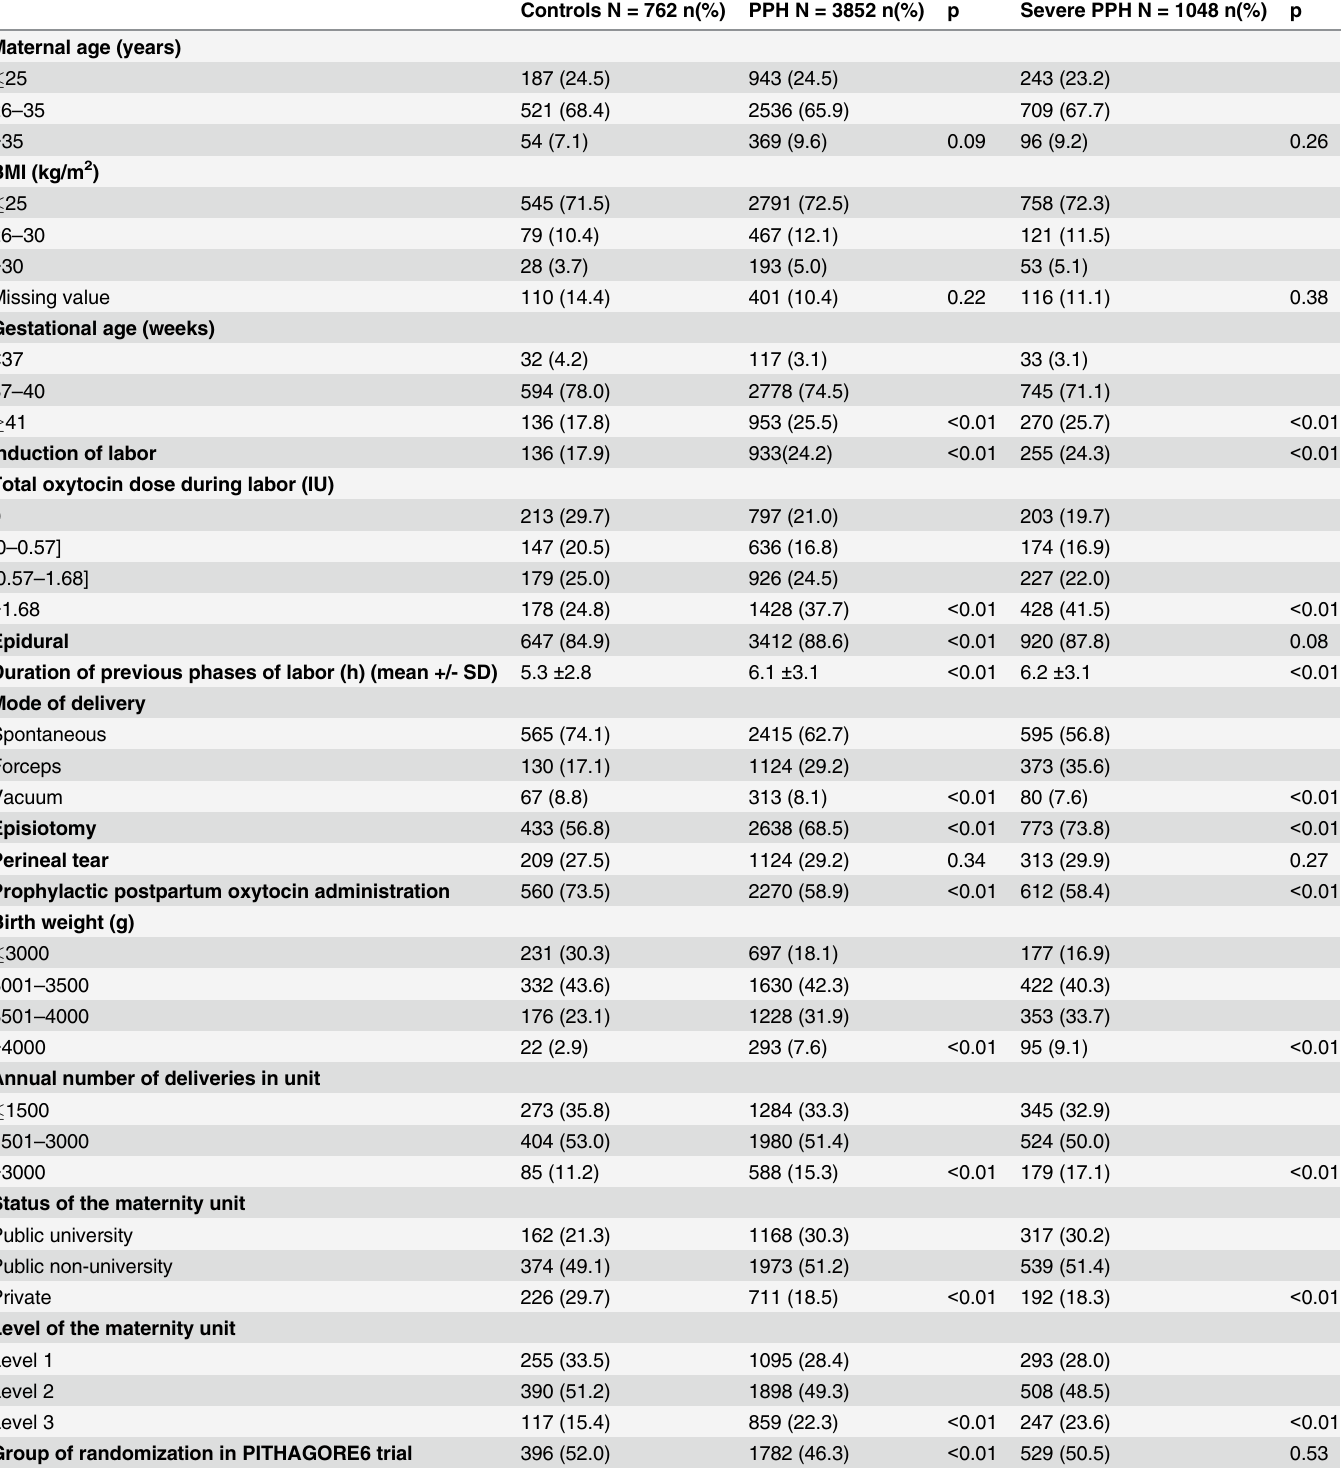
Table 1. Characteristics of cases and